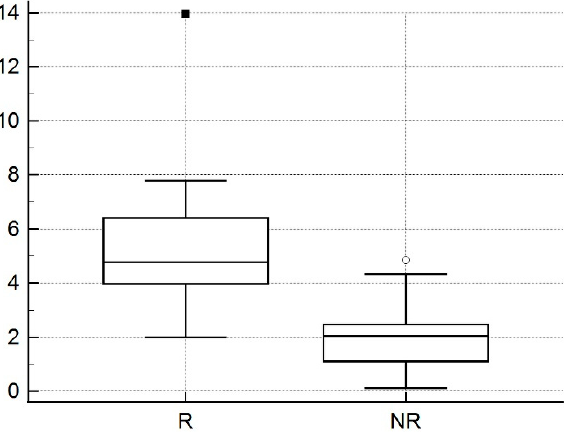
Figure 3. Box and whisker plot of mean trans-registration error (TRE). TRE from nonrigid registration (NR) was statistically smaller than TRE from rigid registration (R).